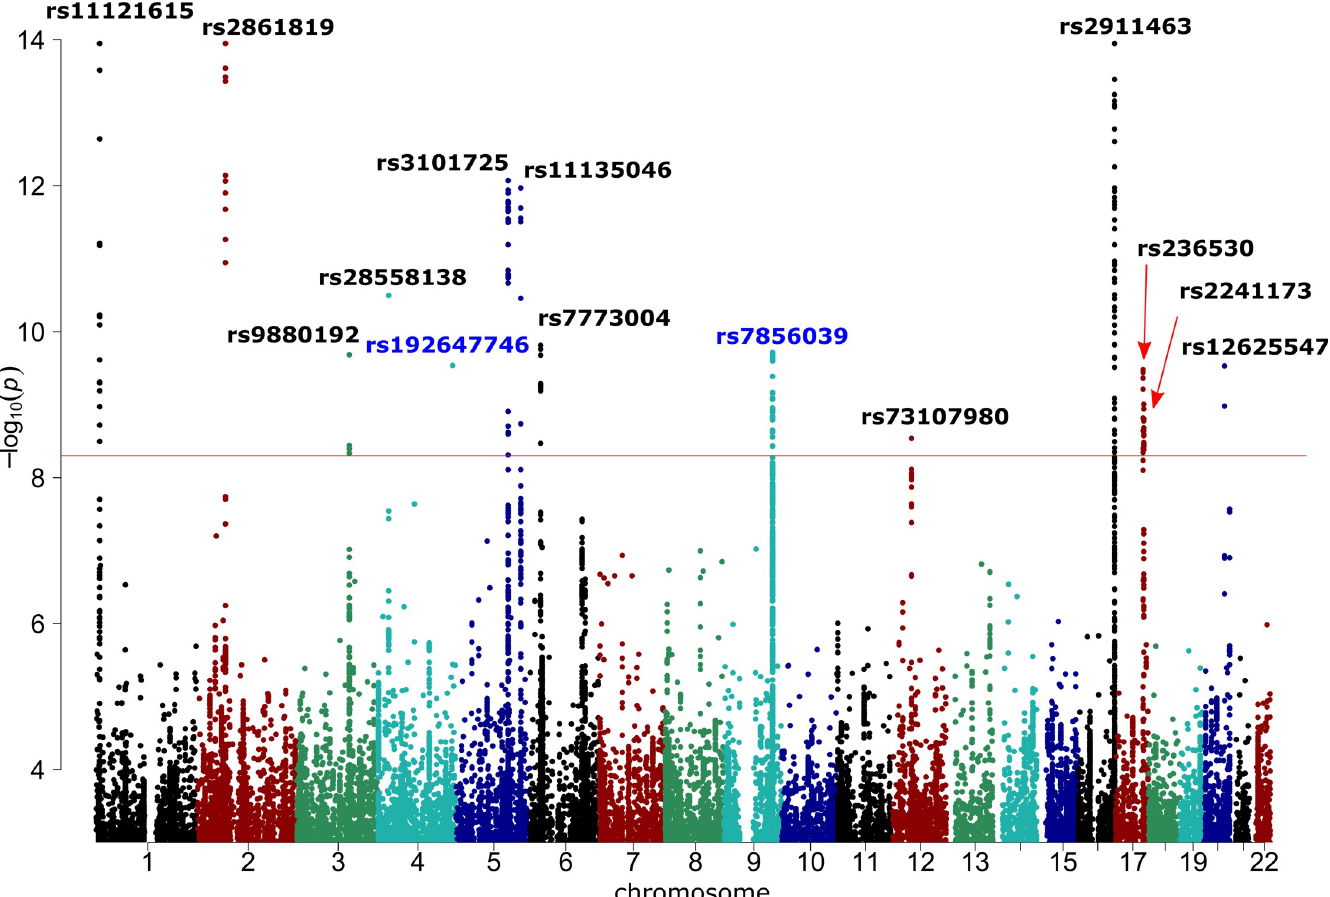
Fig 2. Graphical summary of GWAS results after the adjustment of the Neale Lab data for DVT and BMI and the genomic control correction using LD Score regression intercept. Red line corresponds to the genome-wide significance threshold of P = 5.0e-09. Only associations with P < 1.0e-03 are presented. Points with -log 10 ( P ) > 14 are depicted as points with -log 10 ( P ) = 14. Loci for which P -values in the Gene ATLAS dataset were higher than the corresponding P -values in the Neale Lab dataset are annotated in blue. These loci were not included in further